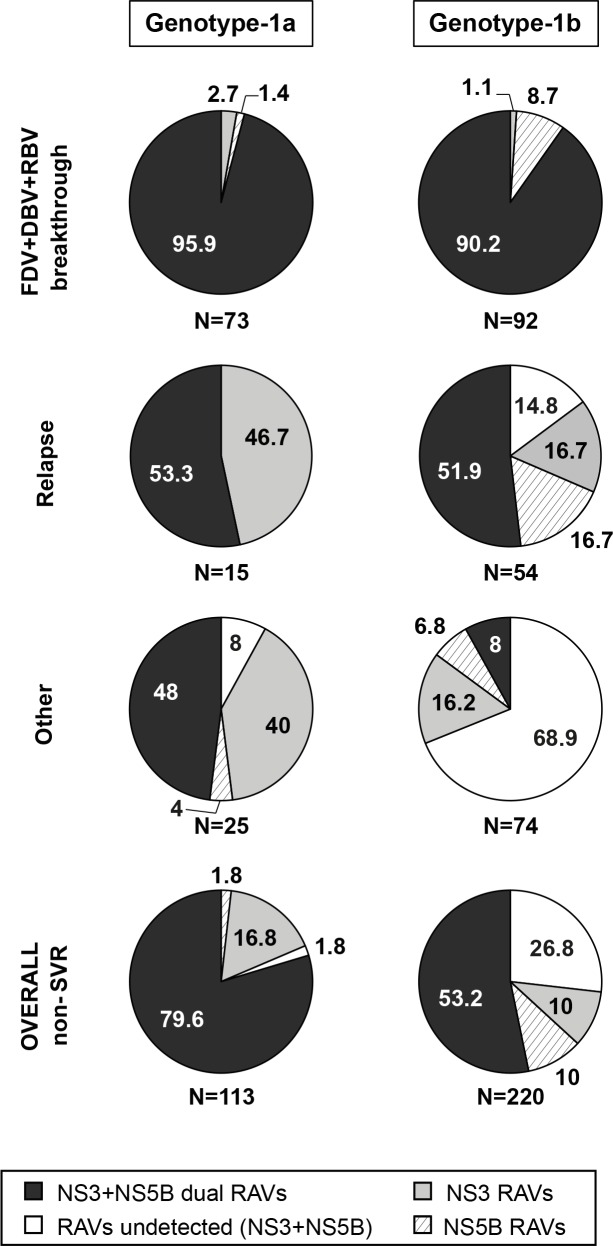
Treatment-emergent RAVs in NS3, NS5B, or both among patients who did not achieve SVR12 with faldaprevir/deleobuvir/RBV.Pooled data: SOUND-C2 (RBV-containing arms only), SOUND-C3, and HCVerso1 and 2. Only patients with sequence data available are shown. NS3 RAV: R155 and/or D168 variants with or without S61L, or single A156 variants. NS5B RAV: P495, P496, A421V, and/or V499A variants. Reasons for non-SVR12 are described in ‘Materials and Methods’. DBV, deleobuvir; FDV, faldaprevir; RAV, resistance-associated variant; RBV, ribavirin; SVR12, sustained virologic response 12 weeks after treatment.